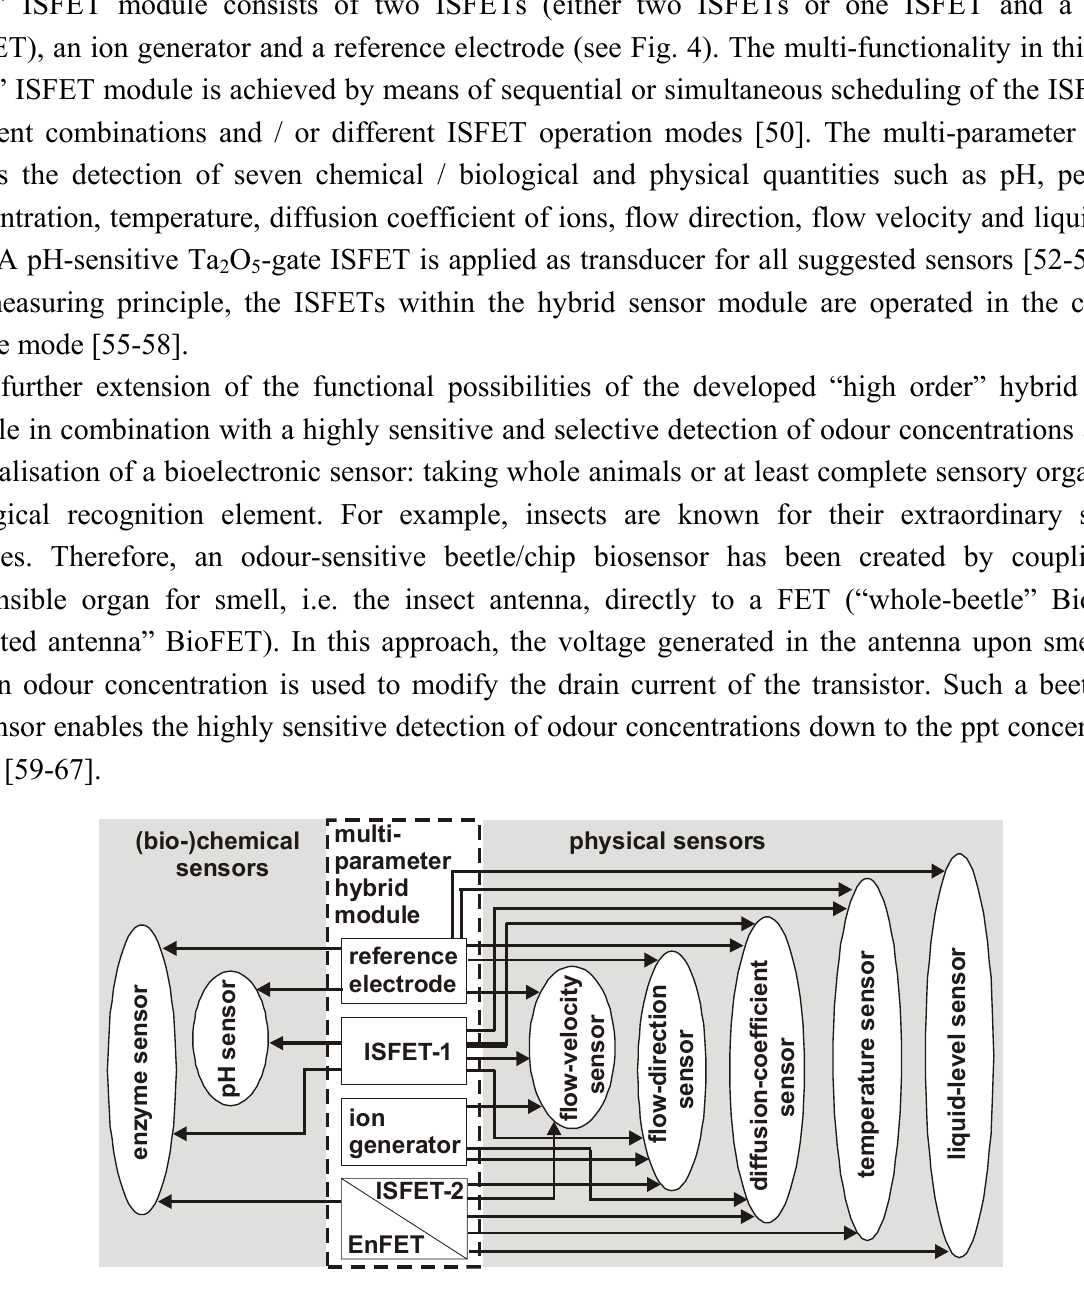
Figure 4. Possible sensor configurations for the measurement of seven (bio-)chemical / physical parameters using the ISFET-based “high order”